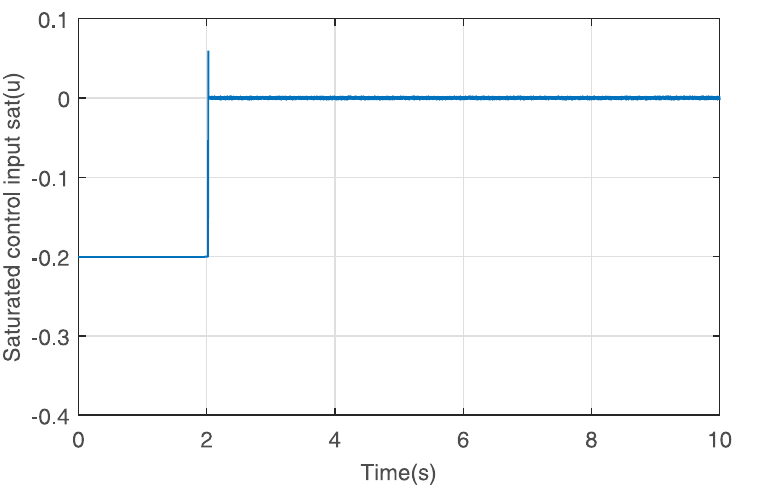
Fig 3. Response curve of the saturated control input sat ( u